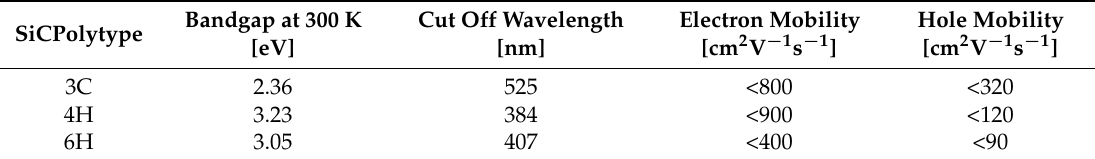
Table 1. The properties of SiC